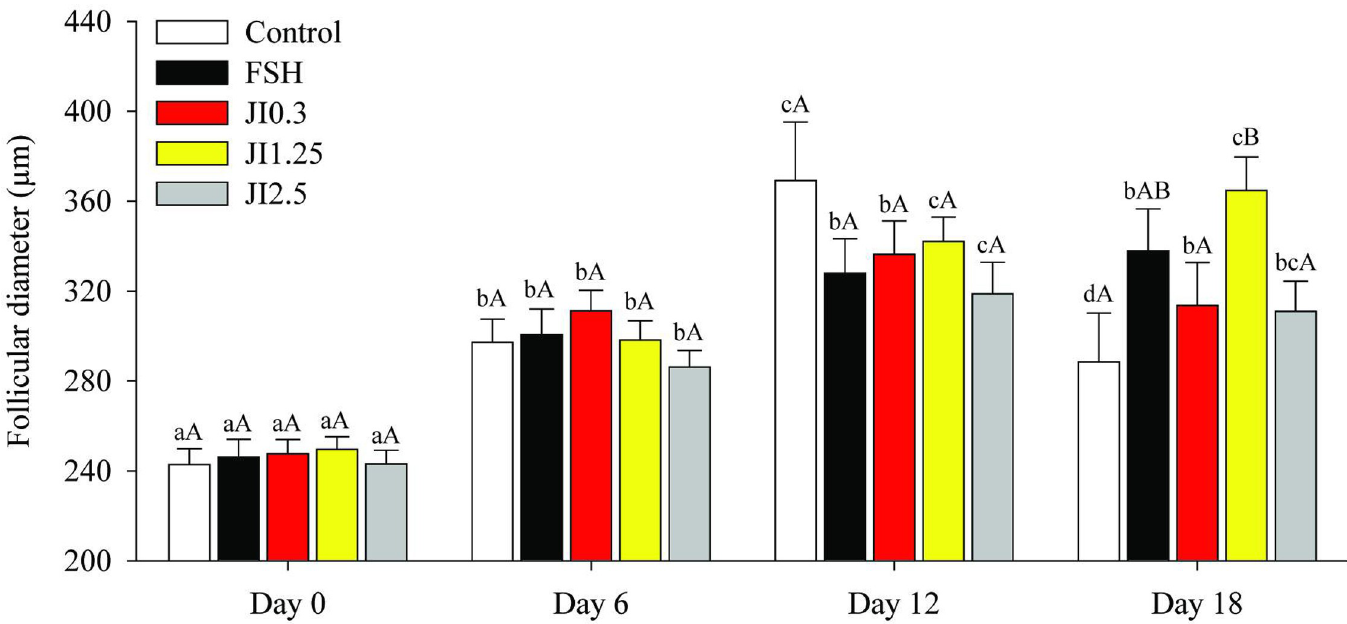
Fig 3. Follicles diameter at different time point (D0, D6, D12, D18) in MEM + (Control), FSH or in J . insularis 0.3, 1.25 or 2.5 mg/mL (JI0.3, JI1.25 or JI2.5 respectively). D: day, MEM + : Minimal essential medium supplemented, FSH: recombinant bovine follicle stimulating hormone, JI: J . insularis . A total of 342 secondary follicles were distributed in the different treatments (n = 6 replicates). a,b,c,d Different letters denote significant differences among time for a given treatment group (P < 0.05). A,B Different letters denote significant differences among treatment groups within the same time point (P <